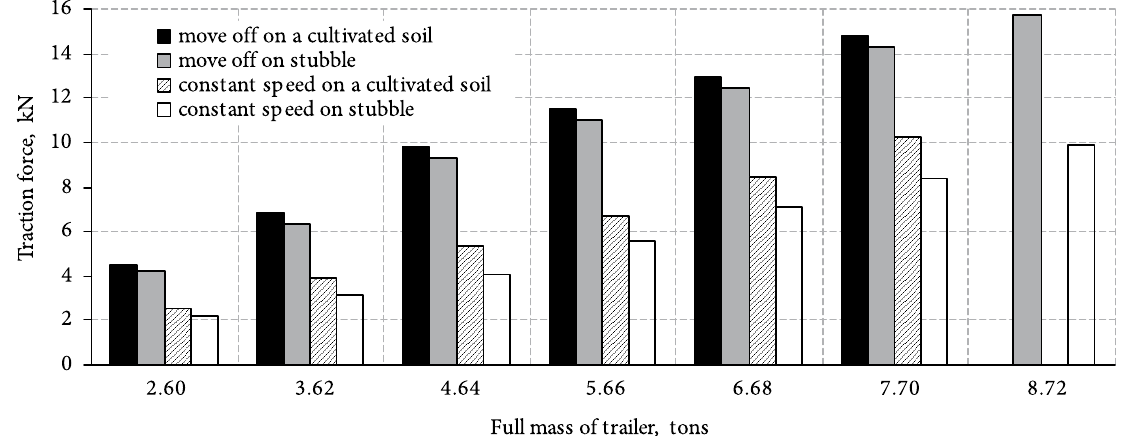
Fig. 3 . The dependence of traction force on the fully loaded trailer